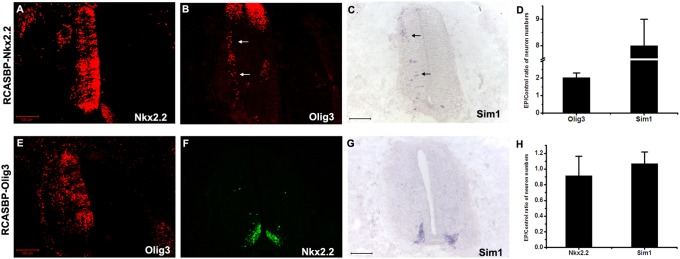
Nkx2.2 overexpression induces ectopic Olig3 expression.(A–C) The spinal cords of cE2 chick embryos were electroporated in ovo with replication competent RCASBP retroviral vectors harboring Nkx2.2 gene. The embryos were harvested 2 days later (cE4). Over-expression of Nkx2.2 induced ectopic expression of Olig3 and V3 interneuron marker Sim1. Ectopic Olig3+ and Sim1+ neurons are indicated with arrows. (D) The ratio of the positive cells generated in the Nkx2.2 electroporated (EP) and the control side of the spinal cord. p<0.005. (E–G) Over-expression of Olig3 did not affect Nkx2.2 and Sim1 expression. (H) The ratio of neuron numbers generated on Olig3 electroporated side and the control side. p>0.05. The dorsal part is up. Bars, 100 µm.